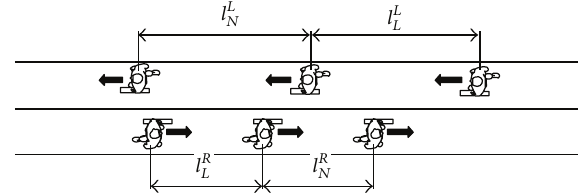
Figure 2: Simplified pedestrian distributary.